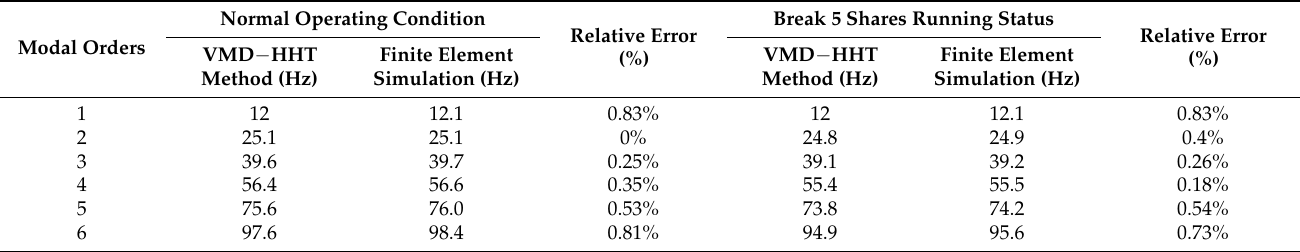
Table 3. Comparison of inherent frequency results obtained from VMD method and FEM simulation modal